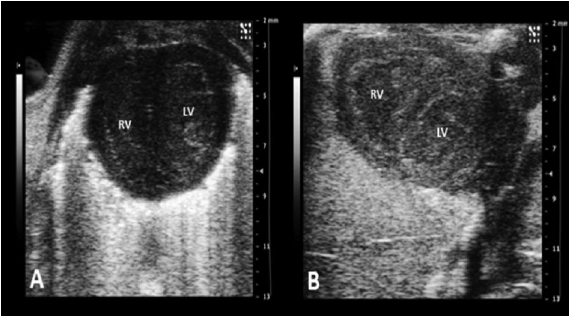
Figure 2. Echocardiographic short axis view from neonatal rabbits. A , control group; B , congenital diaphragmatic hernia (CDH) group. RV: right ventricle; LV: left ventricle. Note RV enlargement in CDH